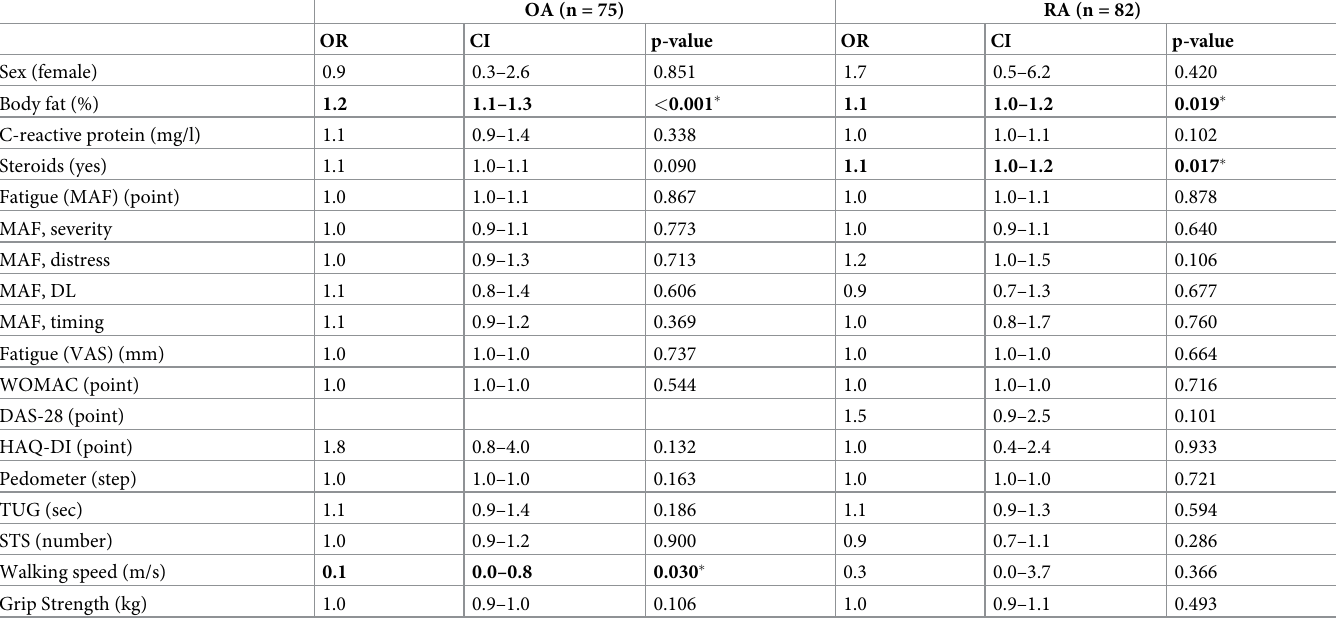
Table 4. Summary of logistic regression analysis for sarcopenia, adjusted for